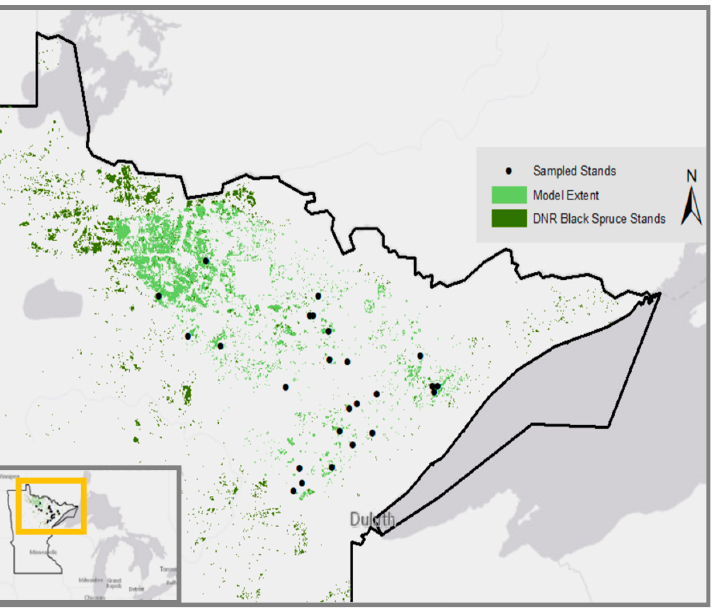
Figure 1. Study area, showing state-managed black spruce stands (green), stands including in the Hanks et al. (2011) model (light green), and stands sampled for model benchmarking (black).